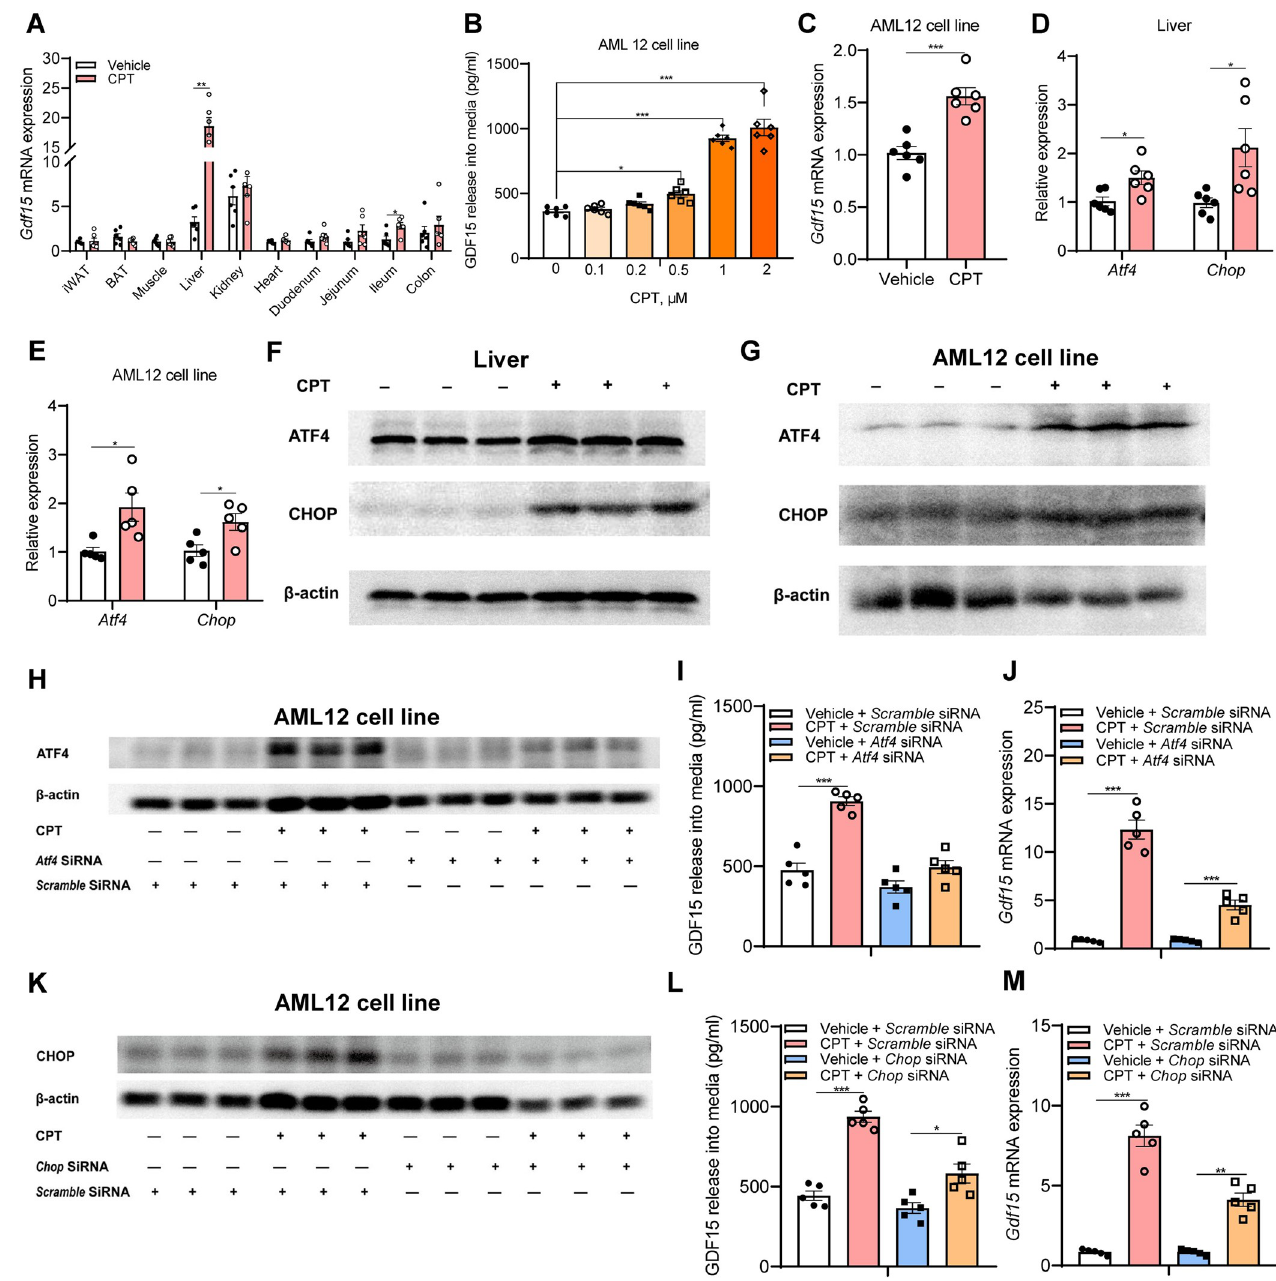
Fig 4. CPT increases GDF15 release from hepatocytes through activation of ISR pathway. (A) Gdf15 mRNA expression in iWAT, BAT, skeletal muscle, liver, kidney, and gut of DIO mice after 30 days of treatment ( n = 6). (B) GDF15 release in medium of cultured hepatocytes (AML12) treated with indicated doses of CPT for 24 h ( n = 6). (C) The induction of Gdf15 mRNA expression by 1 μ M CPT treatment for 24 h in AML 12 cells ( n = 6). (D) mRNA expression levels of Atf4 and Chop in livers of DIO mice after 30 days of treatment ( n = 6). (E) mRNA expression levels of Atf4 and Chop in 1 μ M CPT-treated AML12 cells for 24 h ( n = 5). (F-G) Immunoblot analysis of ATF4 and CHOP relative to β -actin in livers of DIO mice treated with 1 mg kg − 1 of CPT for 30 days and in AML 12 cells treated with 1 μ M CPT for 24 h ( n = 3), respectively. (H) siRNA knockdown of Atf4 blunts 1 μ M CPT-induced ATF4 expression ( n = 3). (I-J) GDF15 release and relative Gdf15 expression in control siRNA and Atf4 siRNA transfected AML 12 cells treated with 1 μ M CPT for 24 h ( n = 5). (K) siRNA knockdown of CHOP blunts CPT-induced CHOP expression ( n = 3), (L-M) GDF15 release and relative Gdf15 expression in control siRNA and Chop siRNA transfected AML 12 cells treated with 1 μ M CPT for 24 h ( n = 5). Data are presented as mean ± SEM. � P < 0.05, �� P < 0.01, ��� P < 0.001. The underlying data for this figure can be found in S1 Data . The original blot for this figure can be found in S1 Raw Image . ATF4, activating transcription factor 4; BAT, brown adipose tissue; CHOP, C/EBP homologous protein; CPT, Camptothecin; DIO, diet-induced obese; GDF15, growth differentiation factor 15; ISR, integrated stress response; iWAT, inguinal white adipose tissue.